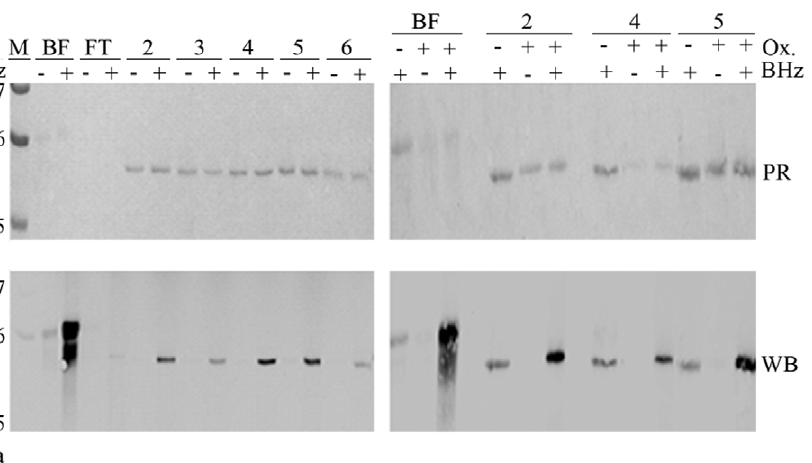
Figure 8. SDS-PAGE analysis of cation exchange chromatography fractions that contain a highly biotin-hydrazide reactive GP. Left panel : The fractions obtained by analysing the flow through of the anion exchange chromatography column by cation exchange chromatography were labelled with Biotin-hydrazide and analysed by SDS-PAGE with Ponceau staining, followed by Streptavidin Western blotting. This revealed the presence of a single highly reactive glycoprotein. This protein was identified as catalase by MS analysis of bands shown in fractions 2 to 6. Right panel : Fractions showing the highest Biotin-hydrazide reactivity on Panel A (fractions 2, 4 and 5) were tested for non-specific reactivity in the presence or absence of periodate oxidation. This showed that periodate oxidation is necessary to obtain full biotin-hydrazine reactivity, therefore demonstrating that reactivity is due to the presence of sugars on the protein. M: Molecular weight marker. BF: bovine fetuine, used as glycoprotein control. FT: flow through of the cation exchange column. Numbers 2 to 6: cation exchange fractions. PR: Ponceau red staining. WB: streptavidin Western blot.